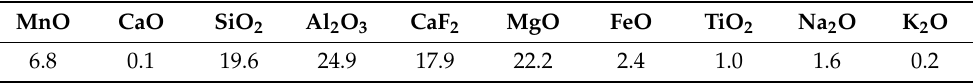
Table 2. Flux composition (mass%).